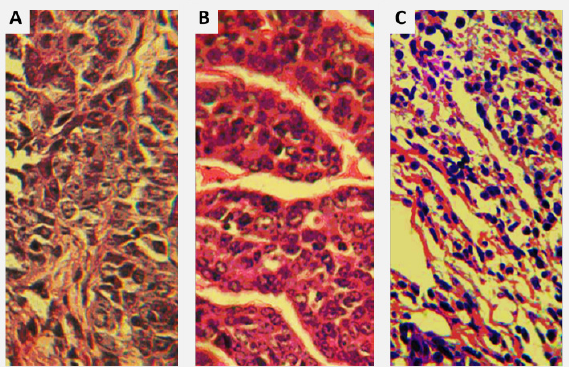
Figure 3. Breast tumor hematoxylin and eosin staining (×400). Note . PAHE: Physalis alkekengi hydroalcoholic extract. (A) Breast tumor in the high clear mitotic body in the control group; (B) and (C) Decreased level of mitotic cells the intensive level of necrotic cells and lymphocytes infiltration into the breast tumors bearing mice 21 days after PAHE treatment (50 & 100 mg/kg) administration, respectively.